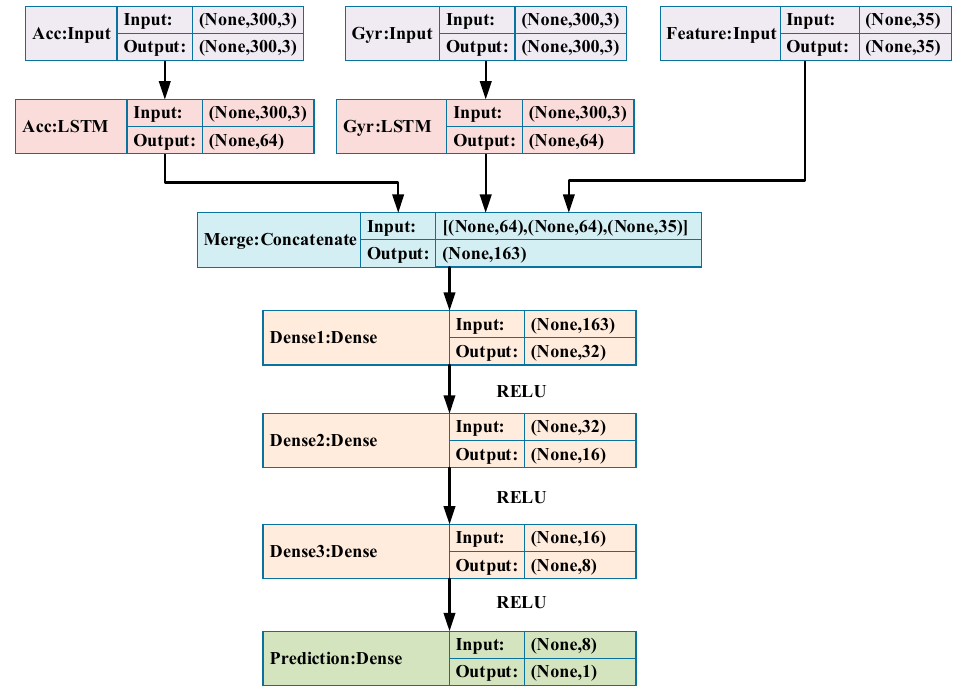
Figure 7. The architecture and parameters of the pure LSTM model.